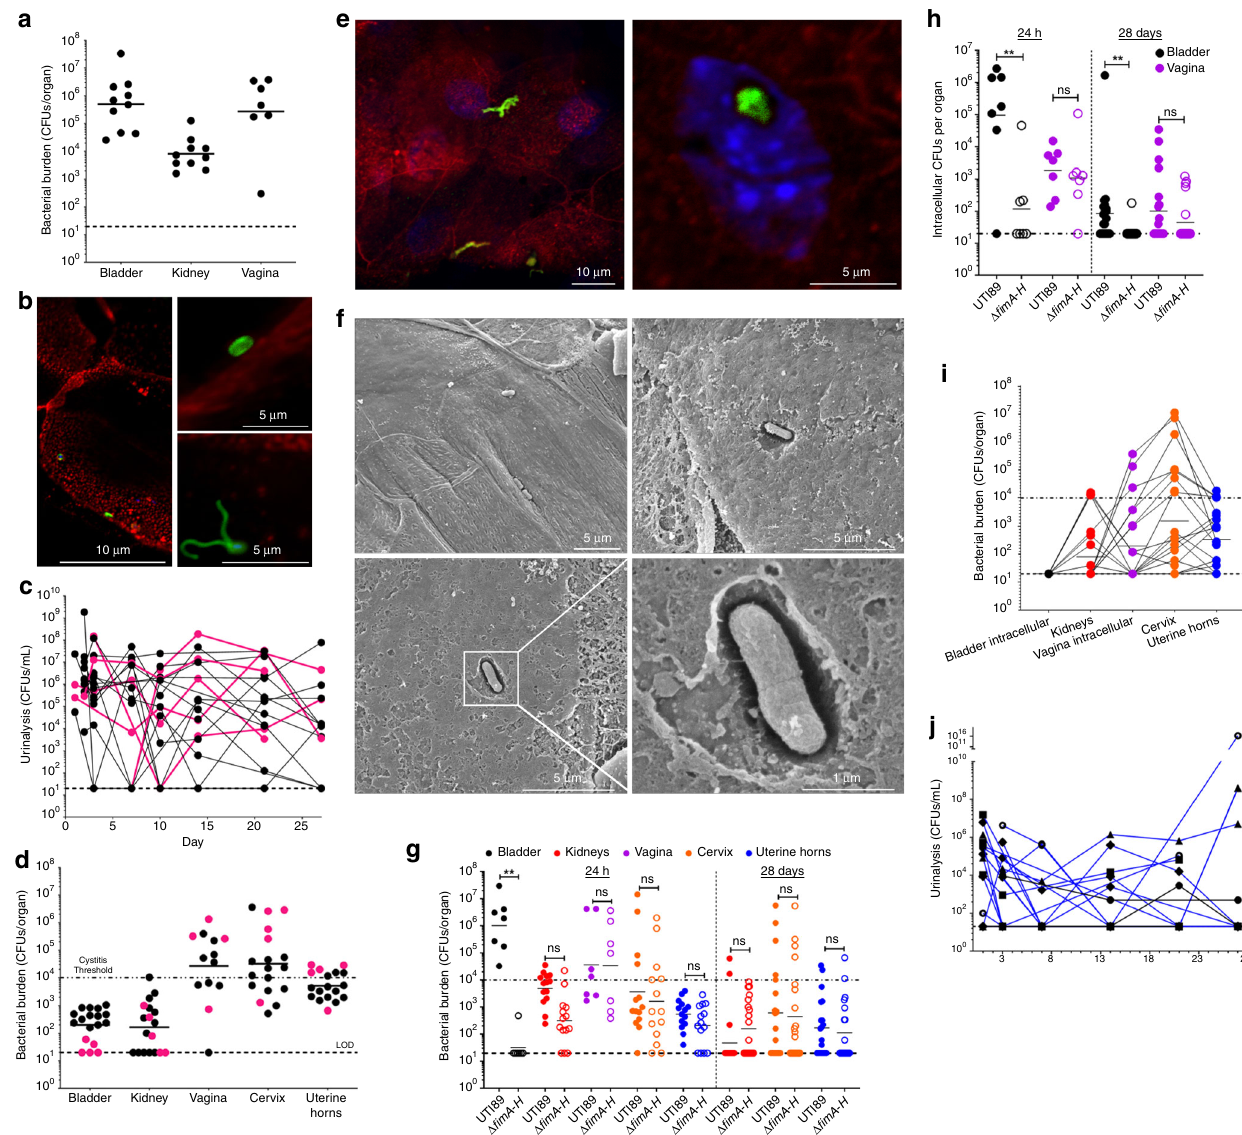
Fig. 3 UPEC invades VECs during colonization of the reproductive tract during and after UTI in murine models. C3H/HeN female mice were trans- uretherally infected with UTI89 in a , b , g , h acute (24-h infection) and c – h chronic (for 28 days) UTI models. a Bacterial burdens of an acute UTI in the bladder, kidneys, and vaginal membranes from mice with an acute infection, and b representative images of immuno fl uorescence of vaginas from three mice. Chronically infected mice c , urine titers d , bacterial burden of organs from urinary and reproductive tract. Pink highlight designates mice at or near the limit of detection (LOD) in the d , bladder and abundant titers in the reproductive tract with c , bacteriuria. e immuno fl uorescence and f SEM performed on vaginal tissue of six chronic mice. Immuno fl uorescence was performed with α - E. coli antibody (green) and rWGA (red) and ToPro-3 (blue) staining showing adherent and intracellular E. coli . SEM revealed membrane invagination around E. coli . The Δ fi mA-H strain is attenuated in g total bladder burden and h bladder cell invasion within acute and chronic murine models; whereas, UTI89 and Δ fi mA-H strains colonize the g vagina, cervix, and uterine horns, as well as, h invade vaginal cells to similar extent. i and j Mice vaginally inoculated with UTI89 and followed for 28 days ( n = 22). j Mice with low urinary tract titers also had the highest level of E. coli in the vagina, cervix, and uterine horns. i horizontal line represents the geometric mean of the organ titers. j Vaginal inoculation of UTI89 resulted in individual mice with bacteriuria (blue lines). When urine titers reached ≥ 1 × 10 4 CFUs/mL mice were separated into a new cage. To assesses organ colonization, samples were homogenized for bacterial titers and to minimize use of animals some samples were set aside for microscopy. Dashed lines represent LOD, and dotted line represents threshold for cystitis. g For statistical analysis two-way ANOVA with Sidak ’ s multiple comparisons test (** P = 0.0013). h For statistical analysis non-parametric Kruskal – Wallis with two-sided Dunn ’ s post-hoc test (** for 24-h P = 0.0062; for 28 days P =